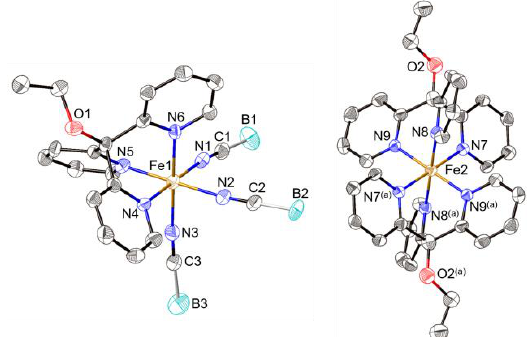
Figure 1. View of the anionic [Fe(py 3 C-OEt)(NCBH 3 ) 3 ] − and the dication [Fe(py 3 C-OEt) 2 ] 2+ complexes in [Fe(py 3 C-OEt) 2 ][Fe(py 3 C-OEt)(NCBH 3 ) 3 ] 2 ·2CH 3 CN ( 2 ) showing the atom labelling scheme and the coordination environment of the two Fe(II) ions (Fe1 and Fe2). Similar structure for [Fe(py 3 C-OEt) 2 ][Fe(py 3 C-OEt)(NCS) 3 ] 2 · 2CH 3 CN ( 1 ). Codes of equivalent positions: (a) = − x, − y, −